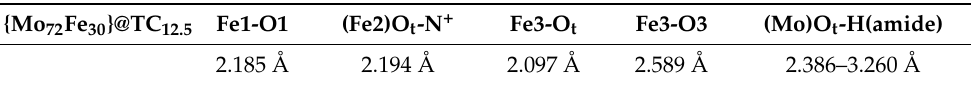
Table 1. Proposed interatomic distances from the model of TC coordination with the {Mo 3 Fe 3 O 6 }